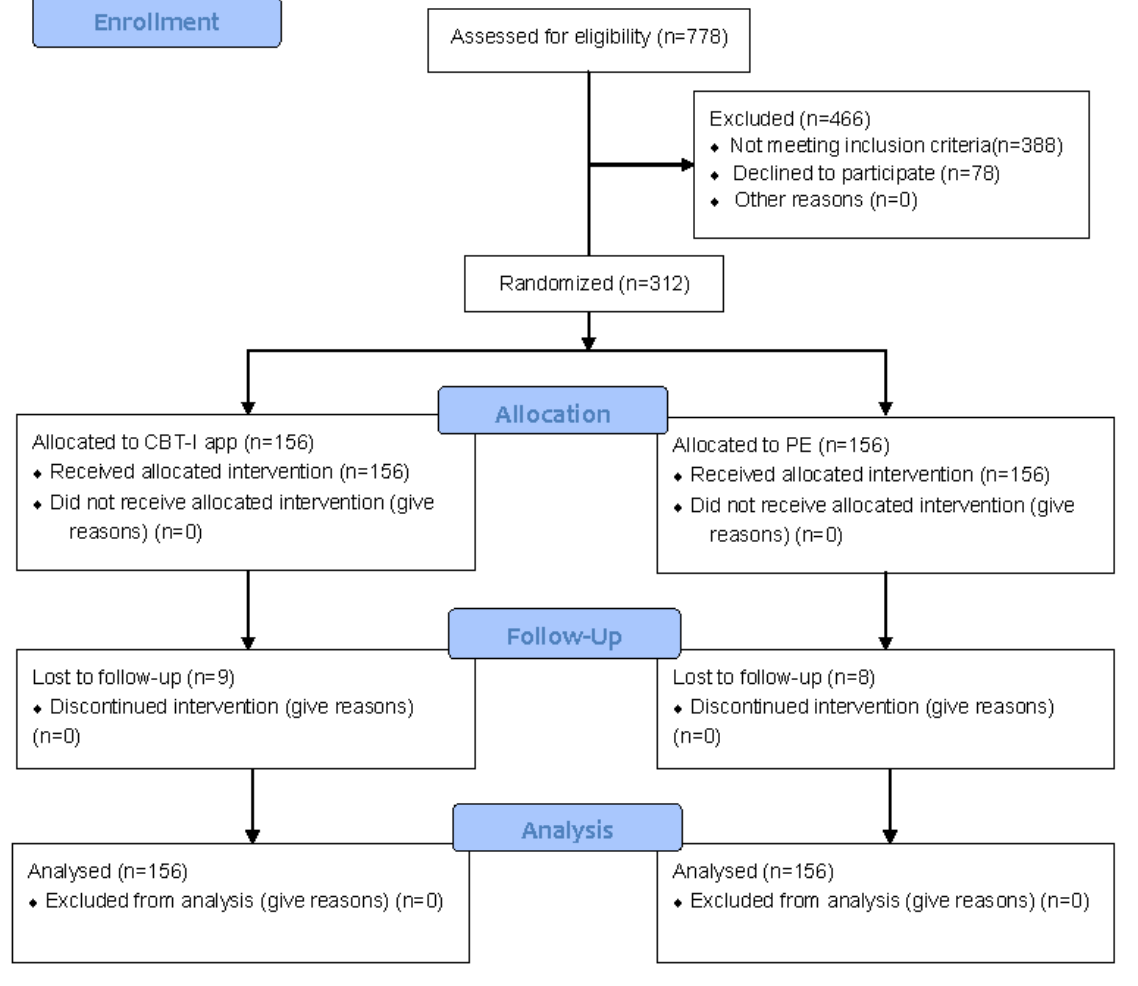
Figure 1. Flowchart of study design. CBT-I: cognitive behavioral therapy for insomnia; PE: patient